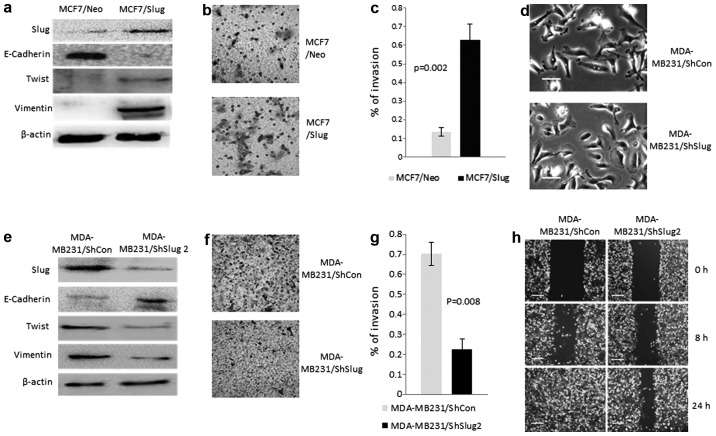
Slug promotes tumor mesenchymal phenotype. (a) Analysis of EMT-associated protein expression by immunoblot. Total protein was extracted using Thermo RIPA buffer from cells treated for 72 h of transient transfection with either Neovector control or Slug plasmid. Proteins (50 μg) from total cell extract for each sample were used for immunoblot. (b and c) Transwell invasion assay of MCF7 cells after 72-h transient transfection with Neovector or Slug plasmid transfection was performed. (b) The image of cell invasion. (c) The percentage of invaded cells by image (error bars indicate SEM; n=3 independent experiments). (d) Morphology image of MDA-MB-231 stably transfected with ShControl vector or ShSlug plasmid. Scale bar, 20 μm. (e) Analysis of EMT-associated protein expression by immunoblot. MDA-MB-231 was stably transfected with ShControl vector or ShSlug plasmid. Total protein from transfected cells was extracted using Thermo RIPA buffer. Protein (50 μg) was loaded for immunoblot analysis. (f and g) Transwell invasion assay of MDA-MB-231/ShCon and MDA-MB-231/ShSlug was performed. (f) The image of cell invasion. (g) The percentage of invaded cells by image (error bars indicate SEM; n=3 independent experiments). (h) Scratch assay shows the reduced motility of MDA-MB-231 cells stably transfected with ShSlug. Scale bars, 100 μm.